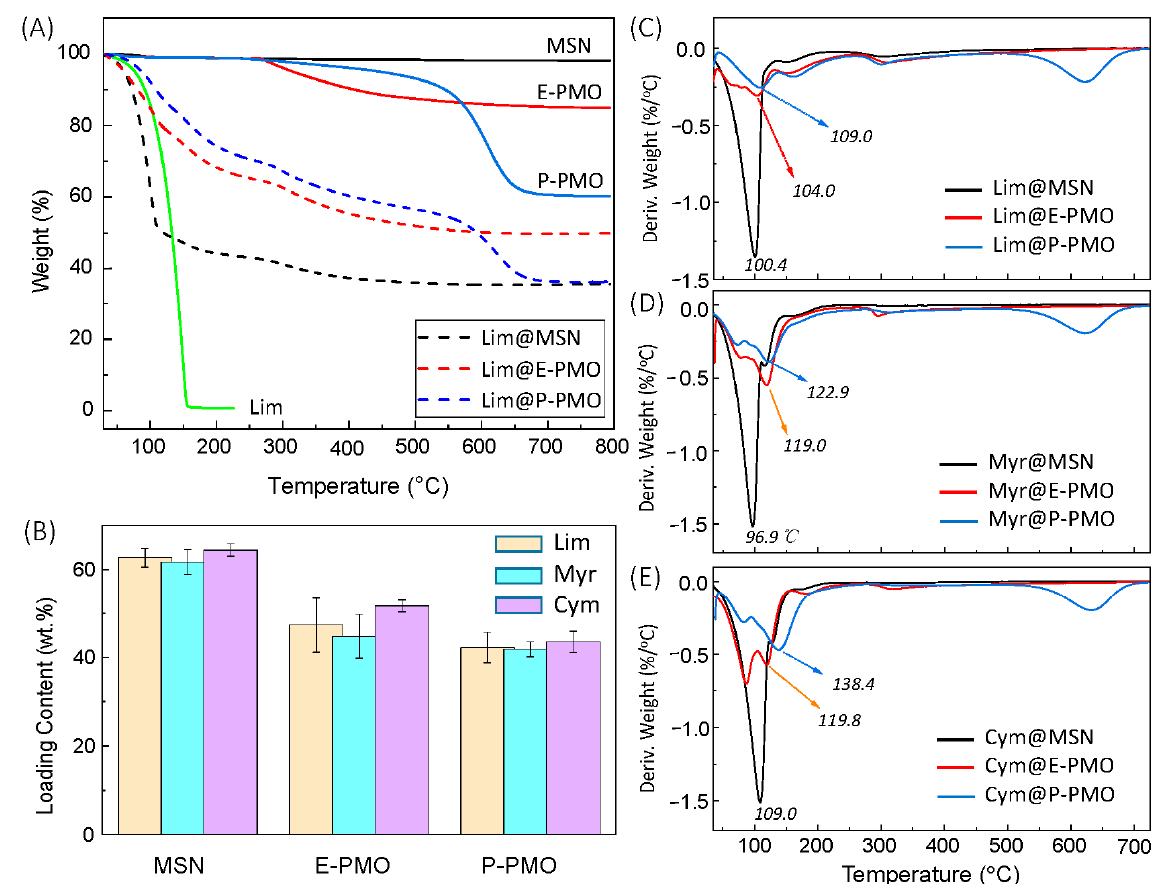
Figure 2. ( A ) Thermal gravity analysis curves of carrier materials, pure D -limonene (Lim), and Lim-loaded composites. ( B ) Adsorption capacities of MSN, E-PMO and P-PMO towards model fragrances, determined by TGA. The loading experiments were conducted in the presence of excess fragrance oils. Right panel: derivative thermal gravity analysis (DTG) curves for nanocomposites loaded with ( C ) D -limonene, ( D ) myrcene, and ( E ) cymene; where black, blue, and red lines represent MSN, E ‐ PMO, and P ‐ PMO nanoparticles, respectively.